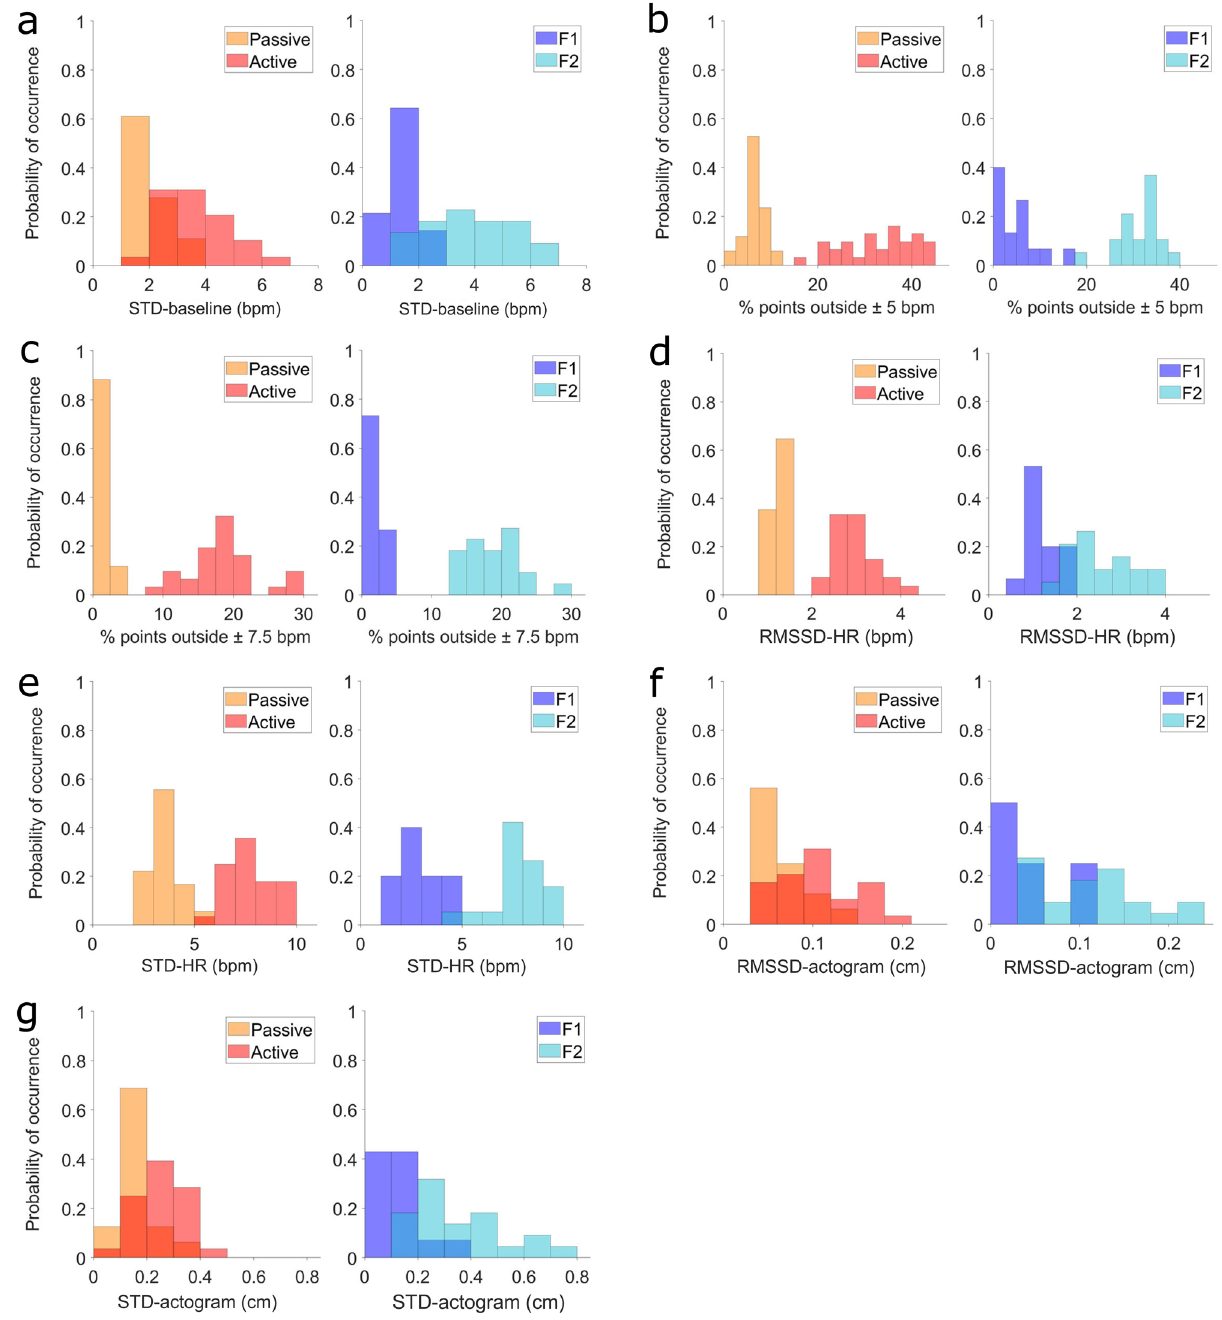
Figure 2. Parameters distributions divided by gestational age. ( a ) STD-baseline (bpm). ( b ) % points outside ± 5 bpm. ( c ) % points outside ± 7.5 bpm (%). ( d ) RMSSD-HR (bpm). e ) STD-HR (bpm). ( f ) RMSSD- actogram, in centimeters (cm). ( g ) STD-actogram, in centimeters